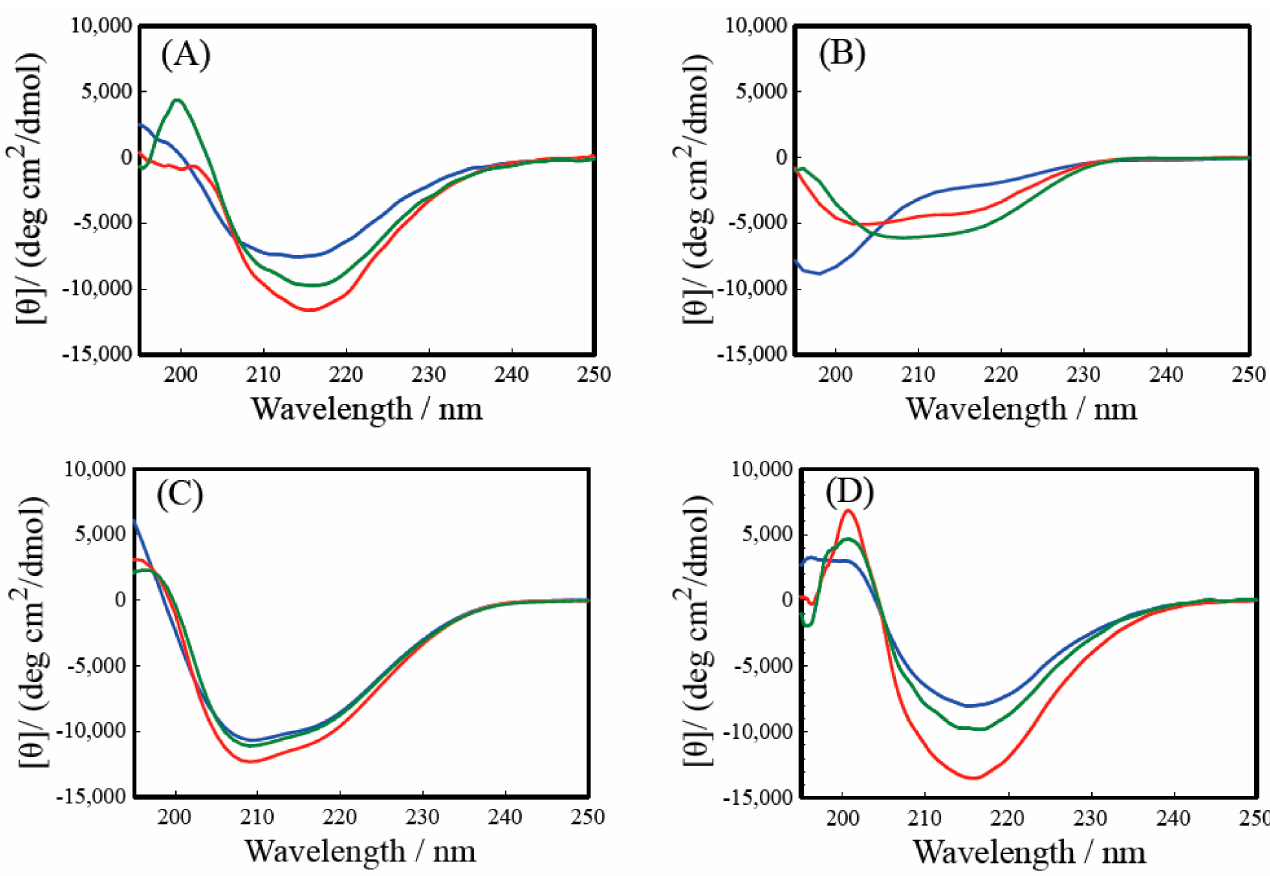
Figure 1. CD spectra of synthetic R-Y derivative peptide. ( A ) R-Y, ( B ) R-Y-RGDS, ( C ) RGDS-R-Y, ( D ) R-RGD-Y. H 2 O: Blue line, 0.06 M NaCl; Green line, 0.10 M NaCl; Red